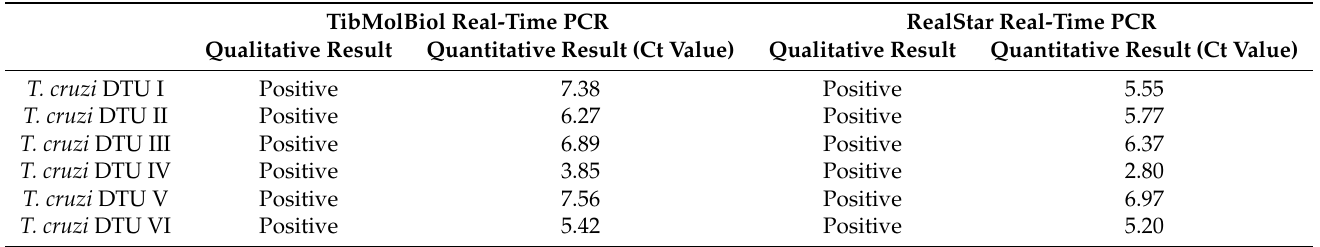
Table 2. Cycle threshold (Ct) values as recorded with nucleic acid extractions of the six DTUs of T. cruzi